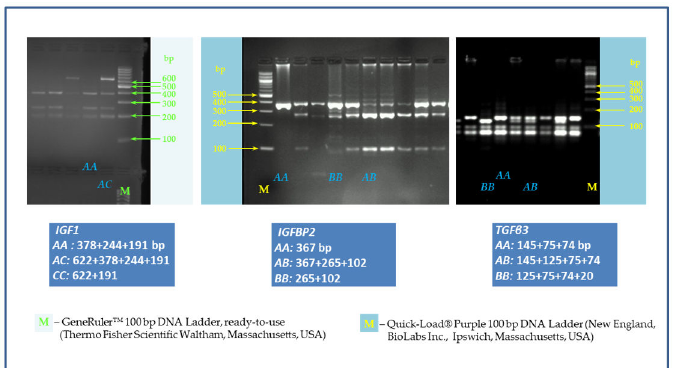
Figure 2. The restriction fragment length polymorphism (RFLP) patterns for IGF1 ( AA: 378 + 244 + 191 bp; AC: 622 + 378 + 244 + 191 bp; CC –it was not detected), IGFBP2 ( AA : 367 bp; AB : 367 + 265 + 102 bp; BB: 265 + 102 bp) and TGF β 3 ( AA : 145 + 75 + 74 bp, AB : 145 + 125 + 75 + 74 bp; BB : 125 + 75 + 74 + 20 bp). Agarose 2%, 120 V, 60 min, Tris-borate-ethylenediaminetetraacetic acid (EDTA) (TBE) bu ff er. M–marker. Table 4. Genotype and allele frequencies of IGF1, IGFBP2 and TGF β 3 genes in the chicken population. Broiler Line Gene Genotype Frequencies a Allele Frequencies a